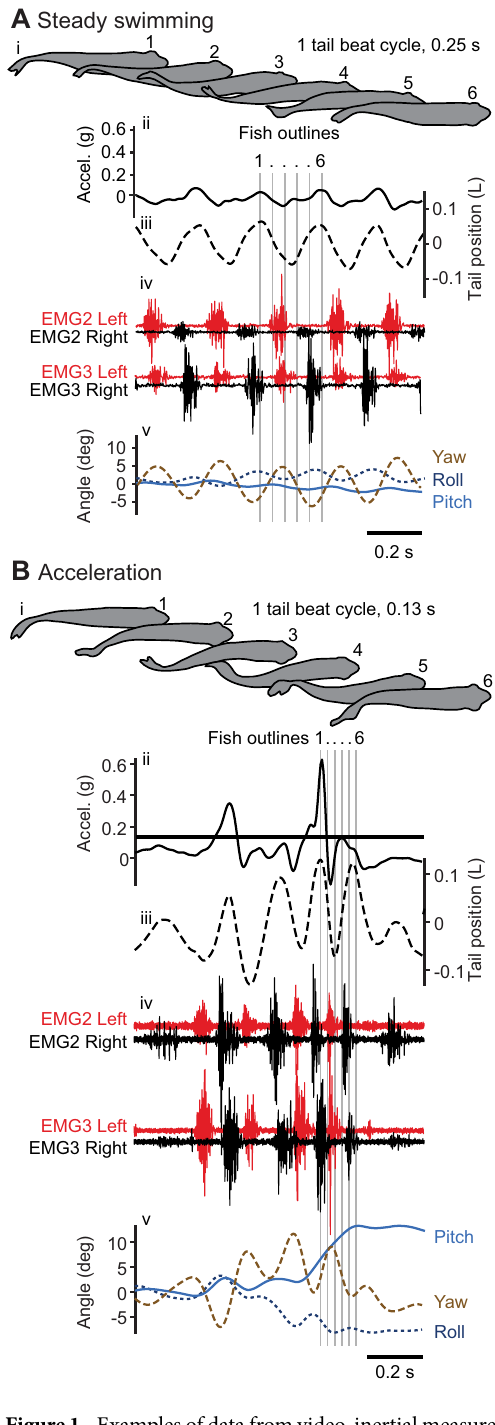
Figure 1. Examples of data from video, inertial measurement units, kinematic measurements, and electromyography. ( A ) Data collected from a steady swimming trial at 2.0 L s − 1 and ( B ) an acceleration trial starting at 1.5 L s − 1 . Fish silhouettes at the top (i) are from one tail beat cycle from the representative trials (labelled 1–6 and spaced out for clarity) and are indicated by grey lines that extend through all traces. The panels below show (ii) forward acceleration (solid black line), (iii) the position of the tail (dash black line), (iv) EMG2 and EMG 3 from both left (red) and right (black) sides of the fish, and (v) roll (dark blue, dashed), pitch (blue), and yaw (brown, dashed). See Movies S1 and S2 for ventral video synchronized with the data shown in A and B,